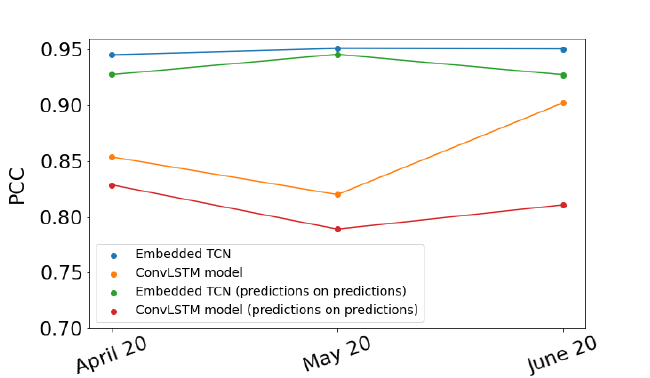
Figure 11. PCC between the predicted values and the ground truth in April, May and June of